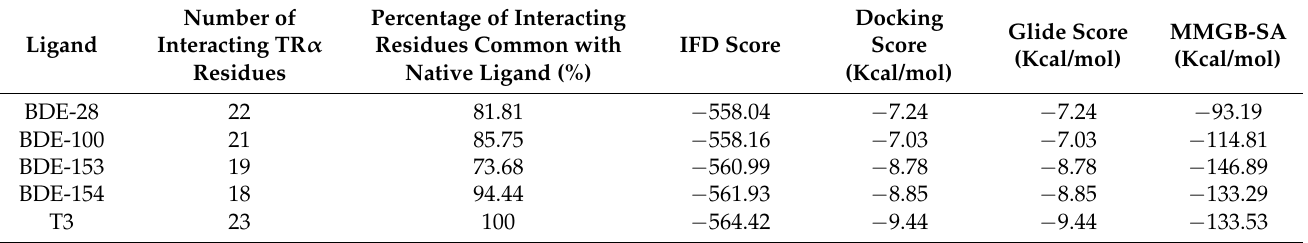
Figure 2. The molecular interactions of a TR α amino acid residues lining the ligand binding pocket with its native ligand, triiodothyronine (T3). Table 1. Structural binding indices of polybrominated diphenyl ethers (PBDEs) flame retardants;